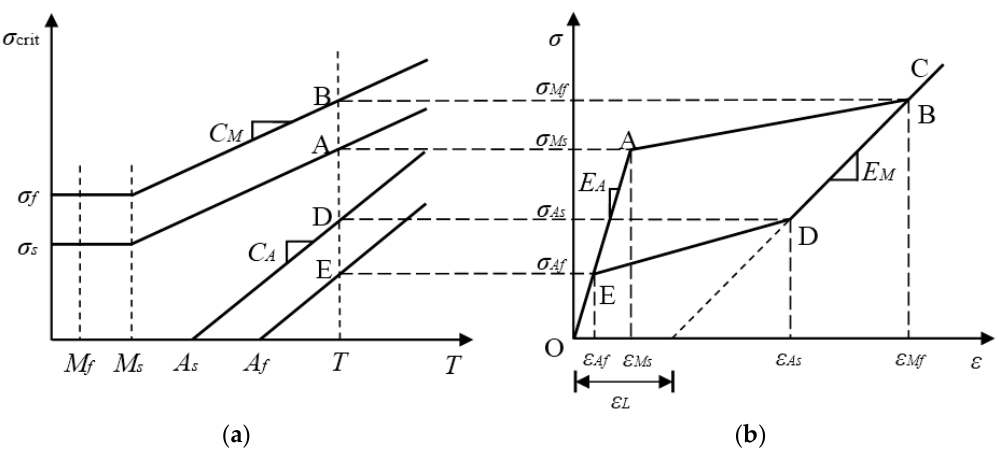
Figure 1. Schematic of the major loop in the multilinear constitutive model: ( a ) critical stress versus temperature; ( b ) superelastic stress-strain behavior.